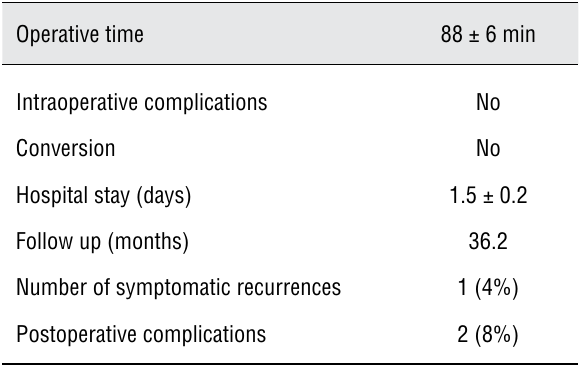
Table 2 - Intraoperative data and outcome.